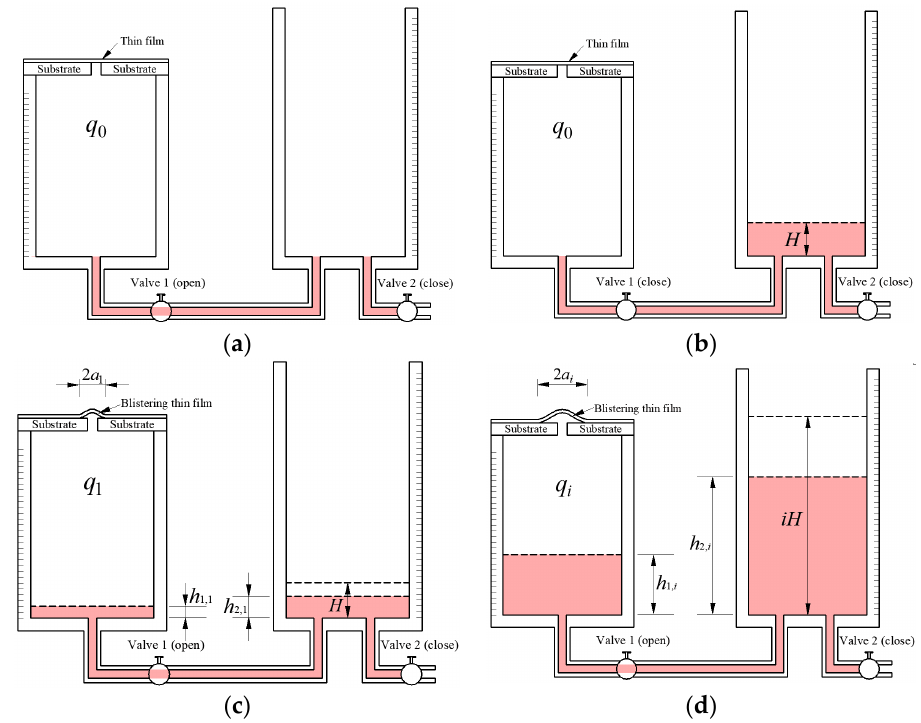
Figure 4. Schematic view of loading process or method of pressurized blister test: ( a ) Initial state; ( b ) Status before opening the valve 1 in step 1 of loading operation; ( c ) Stable state after step 1 of loading operation; ( d ) Stable state after step i of loading operation.